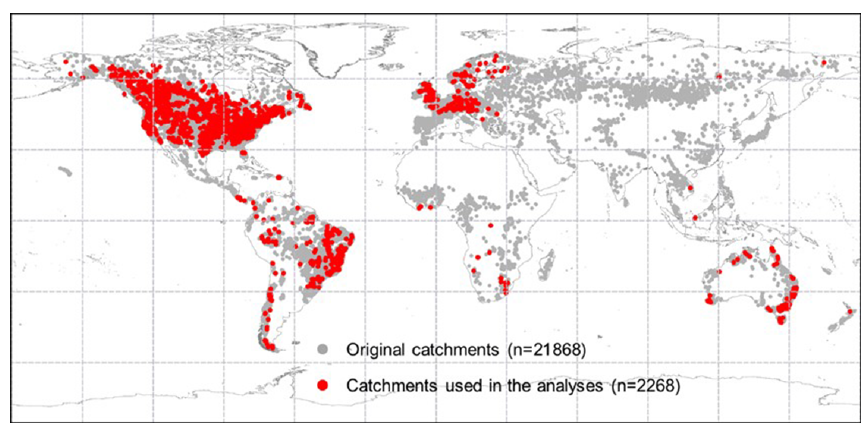
Figure 3. Locations of the catchments across the globe. The grey dots show the locations of the original 21856 catchments, and red dots are the 2268 catchments that pass the selection criteria and are used